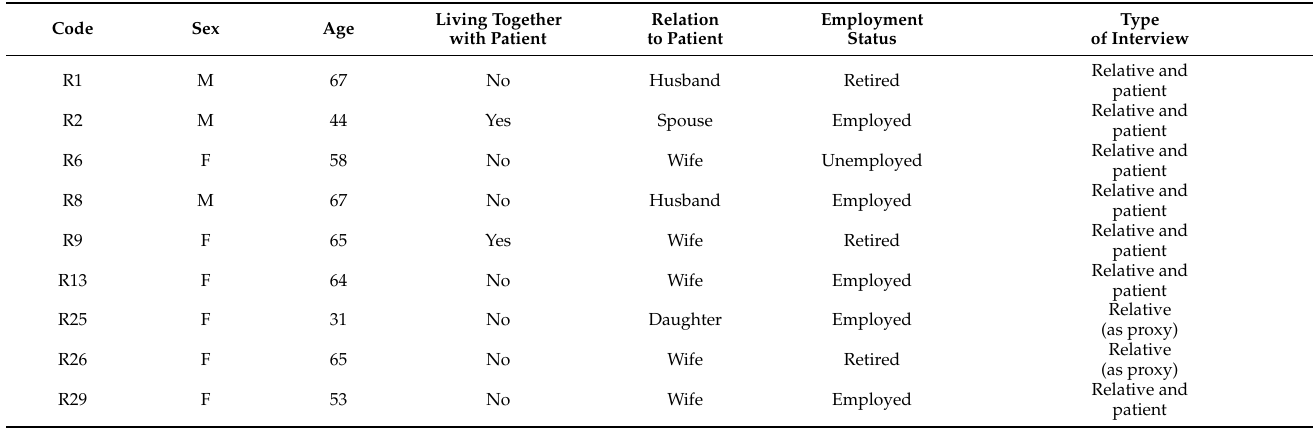
Table 2. Relatives’ sociodemographic characteristics.